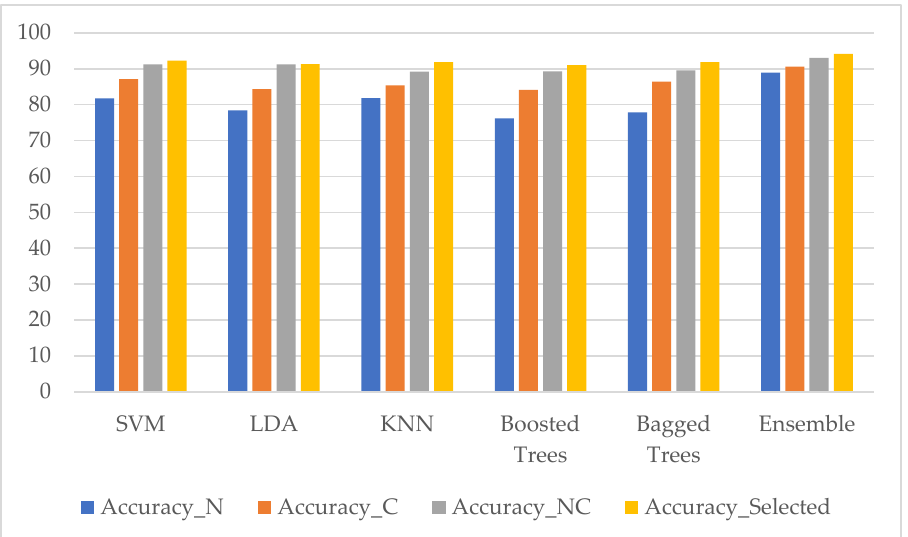
Figure 15. Classification performance of five classifiers and our ensemble classifier in terms of accuracy using four datasets (nuclei features only (Accuracy_N), cytoplasm features only (Accuracy_C), combining nuclei and cytoplasm features without features selection method (Accuracy_NC), and with features selection method (Accuracy_Selected)). (SIPaKMed dataset for the five-class problem).